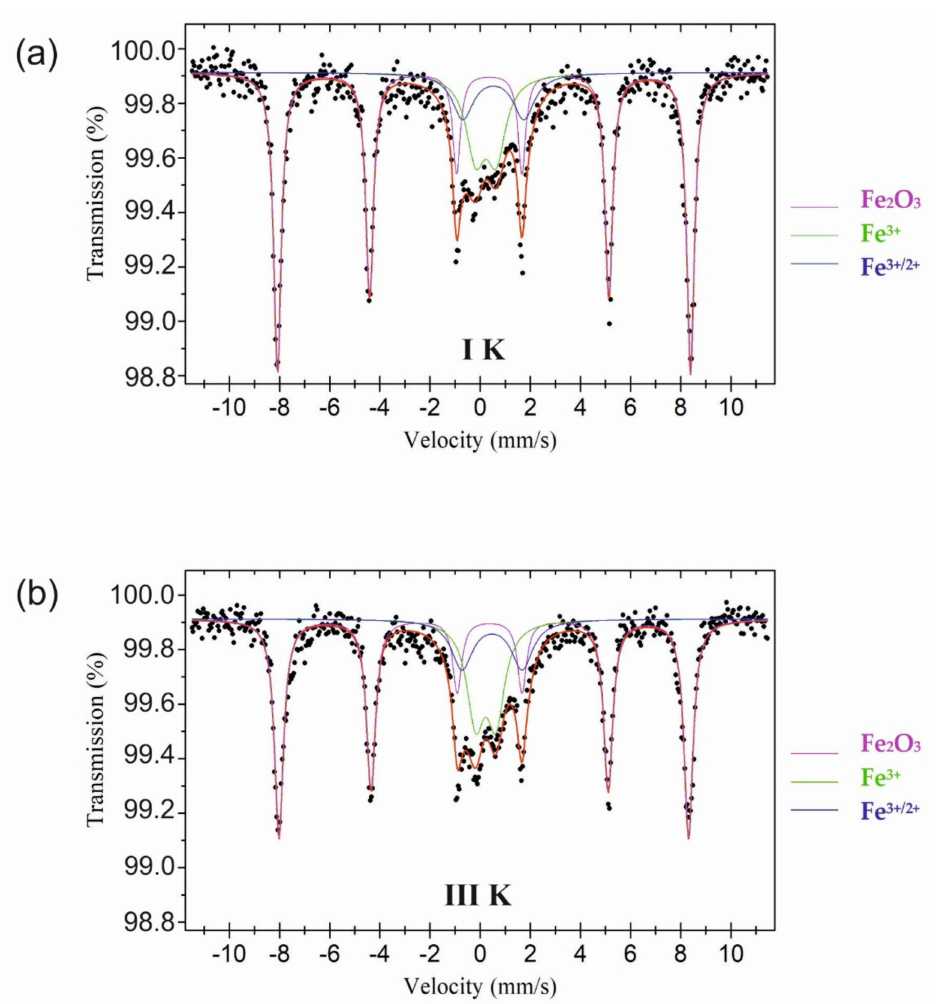
Figure 6. Room temperature Mössbauer spectra of the potassium-rich samples heat-treated at 1200 ◦ C. ( a ) I K doped with Fe 2 O 3 , ( b ) III K doped with Fe 2 O 3 + TiO 2